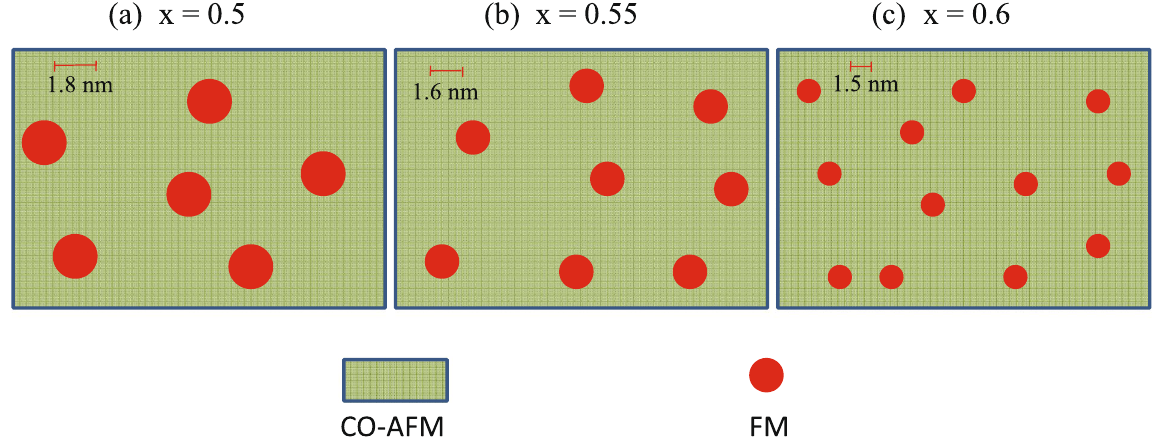
Figure 9. Schematic diagram showing variation of size and density of ferromagnetic clusters in phase co- existing charge ordered Sm 1 − x Ca x MnO 3 (x = 0.5, 0.55 and 0.6)